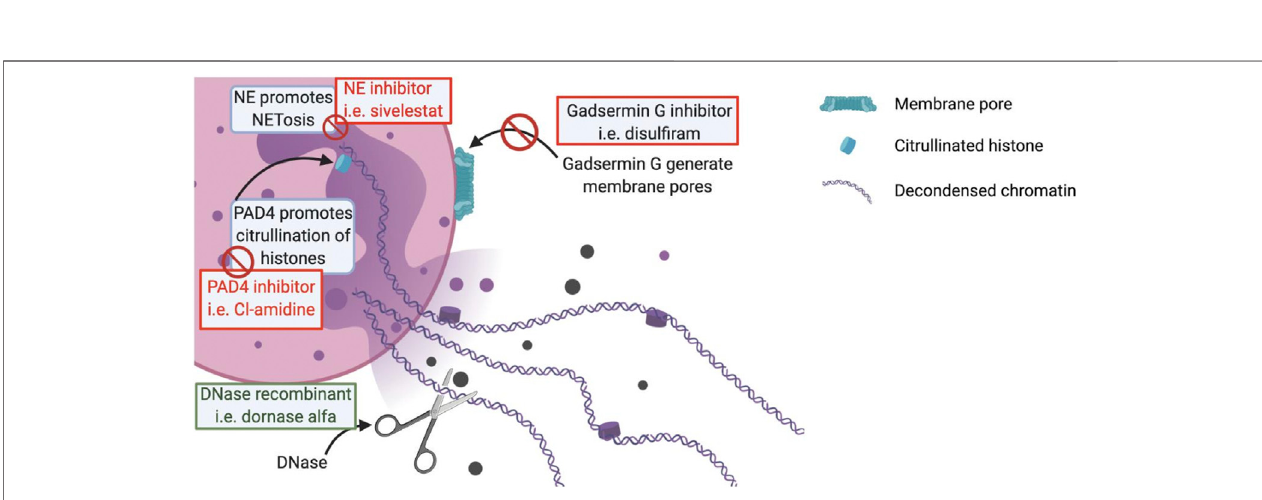
FIGURE2| SchematicrepresentationofaNET.Intheredboxesarementionedthepotentialtreatmentsactingbyinhibitionofthekeymechanismsintheformation of NETs. In the green boxes are mentioned the potential treatments acting by stimulation of different bene fi cial mechanisms in the context of a viral infection.